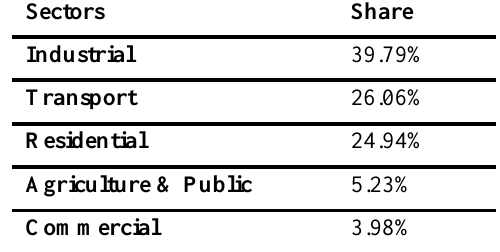
Table.8.Shares of Sectoral Demand for Final Energy